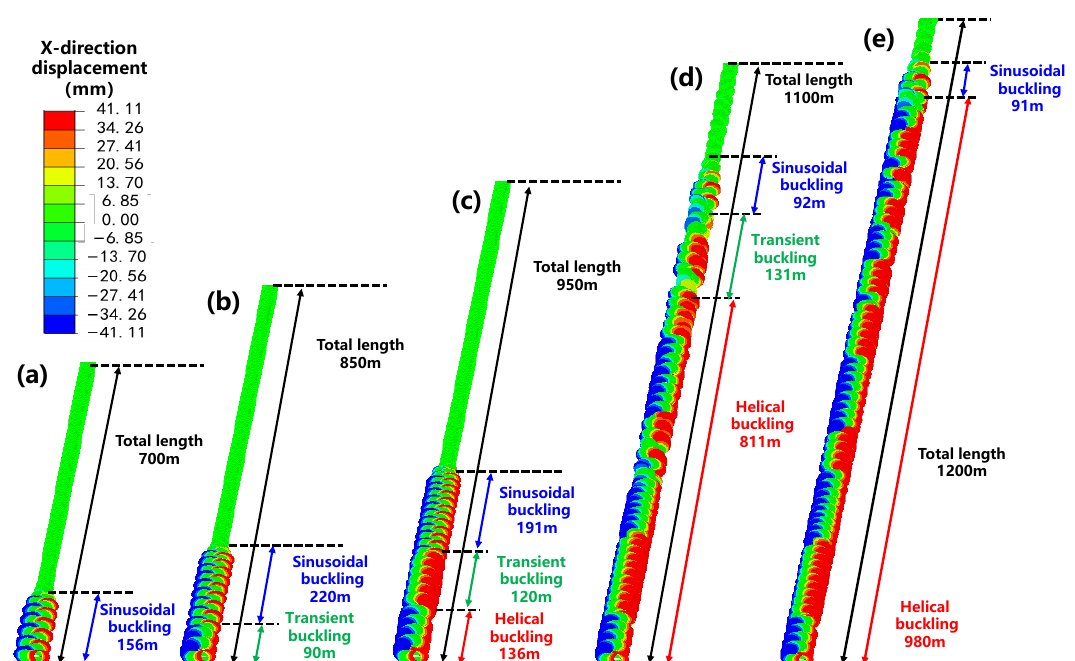
Figure 15. The tubing buckling deformation (expansion joint–packer) under five defined working conditions: ( a ) I condition, ( b ) II condition, ( c ) III condition, ( d ) IV condition, and ( e ) V